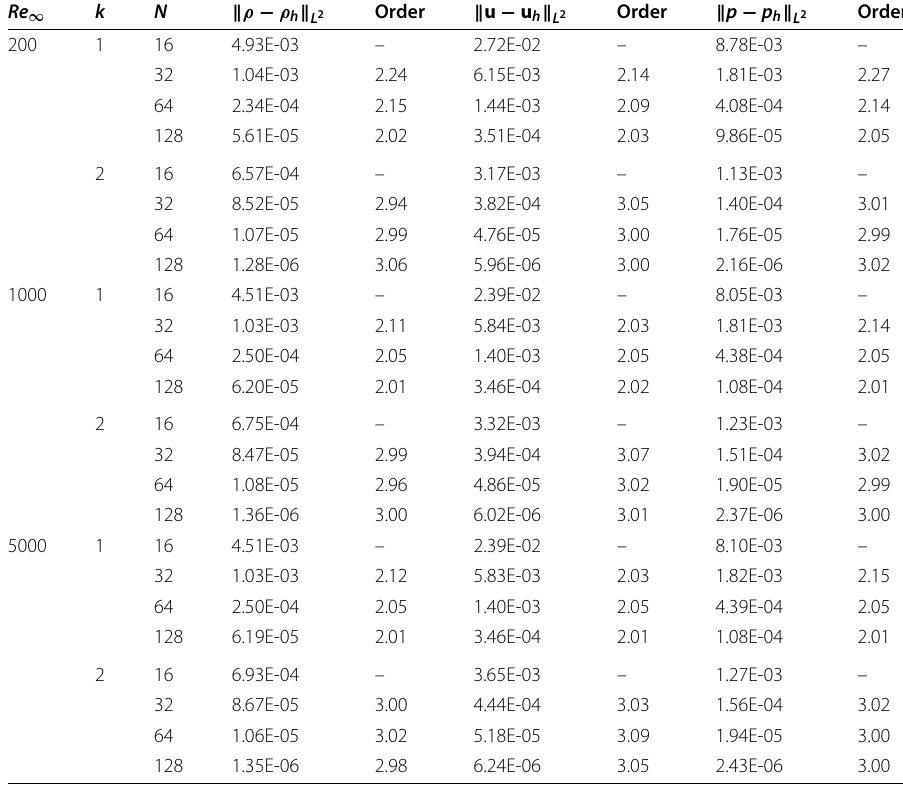
Table 1 Accuracy test for adaptive IMEX-RK-LDG scheme of 2D NS equations Re